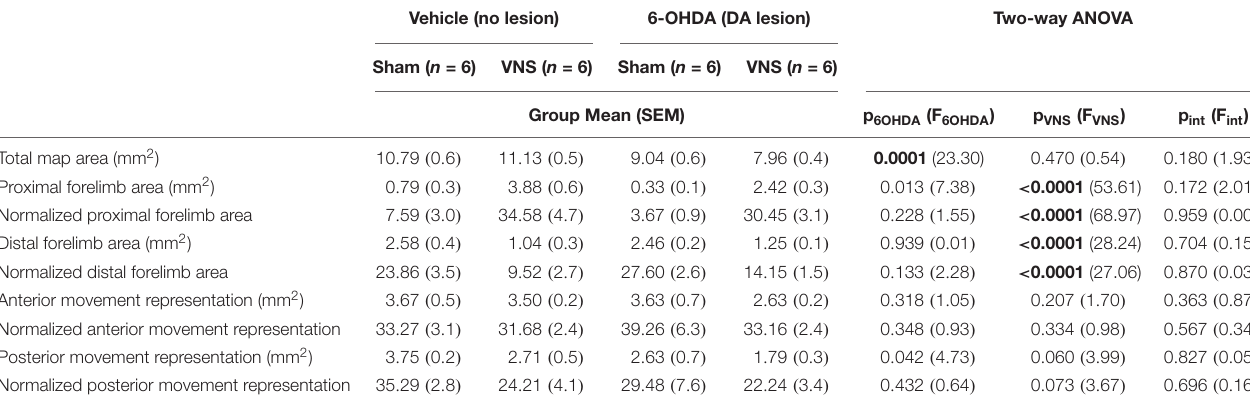
FIGURE 5 | Vagus nerve stimulation drives cortical reorganization even after DA depletion. (A) Representative motor maps from each treatment group. Threshold-evoked movements were determined for each site on a grid (0.5 mm spacing) overlying left motor cortex, and sites were classified as representing proximal forelimb (PFL), distal forelimb (DFL), anterior body (jaw, vibrissa, and neck), or posterior body (trunk, hindlimb, and tail) movements. (B) Total motor map area was significantly reduced following M1 DA depletion. (C) PFL map representations increased as a result of VNS administration, in both vehicle-treated and 6-OHDA infused rats. (D) DFL map representations decreased following VNS, in both vehicle- and 6-OHDA infused rats. In (B–D) , * p < 0.05; ** p < 0.01; *** p < 0.001; **** p < 0.0001, Tukey post hoc tests. TABLE 4 | Training-paired VNS enhances the task-relevant proximal forelimb (PFL) representation in M1, even after cortical dopamine depletion. Vehicle (no lesion) 6-OHDA (DA lesion) Two-way